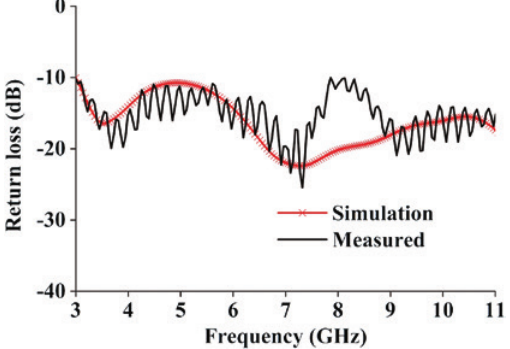
Figure 6: Effects of return loss for different values of S